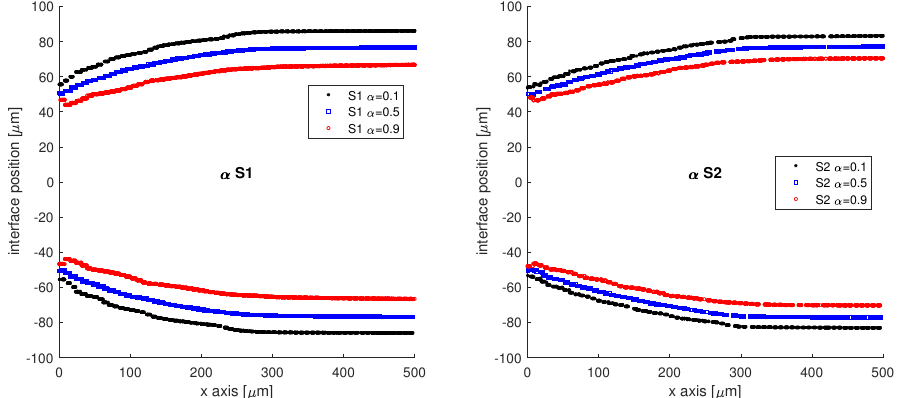
Figure 6. Interface reconstruction on the lines of constant volume fraction of the oil phase, starting from x = 0 µ m to 500 µ m away from the junction; α = 0.5 is considered to be the interface. In Figure 7, the distributions of velocity and vorticity magnitude are presented.